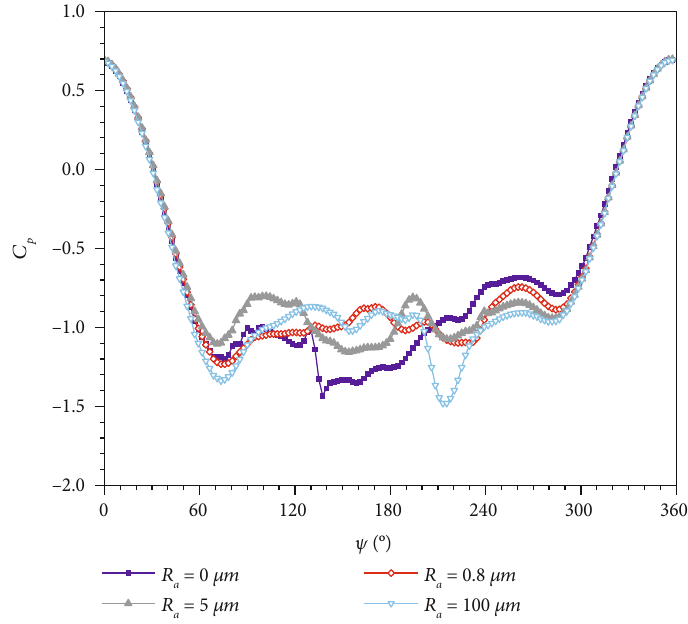
Figure 38: Pressure coe ffi cient distribution of di ff erent models at 5 D